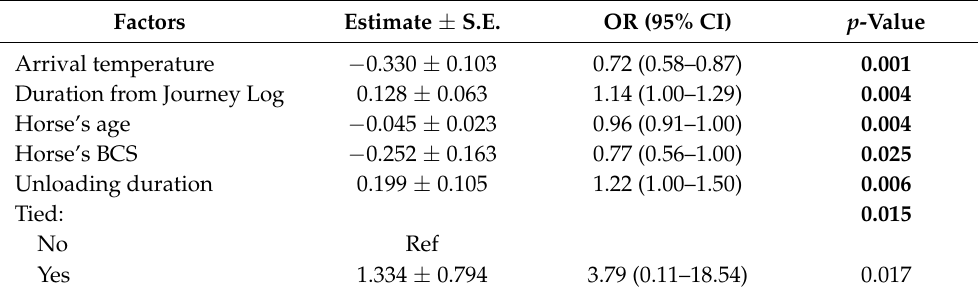
Table 10. Nasal discharge—final multiple regression model for the dummy dependent variable of presence/absence of nasal discharge in handled horses at arrival at the slaughterhouse. Data are presented as estimates and standard errors (S.E.) of the effect, odds ratio (OR), confidence interval (95% CI), and p -value. Bold p -values refer to the statistical significance of the predictive variable in the model; the significance of a category against the reference is reported in regular